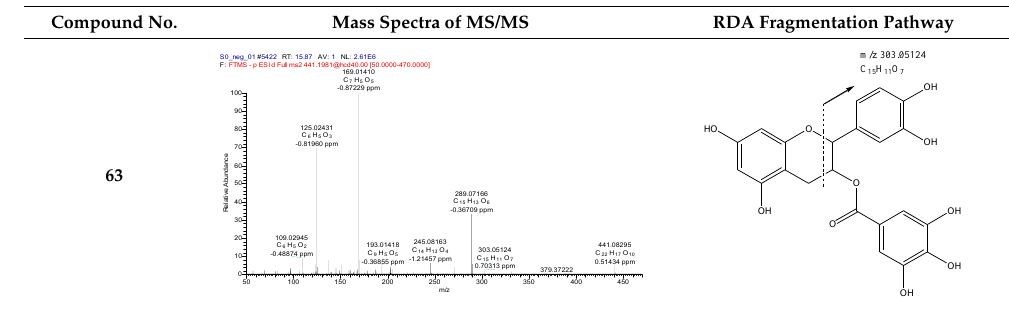
Figure 4. RDA fragmentation pathway of pentacyclic triterpene with endo-double bond.